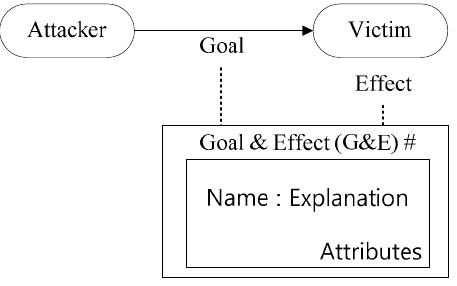
Figure 1. Conceptual diagram of G&E model. G&E has a unique number, a name, an explanation, and attributes.